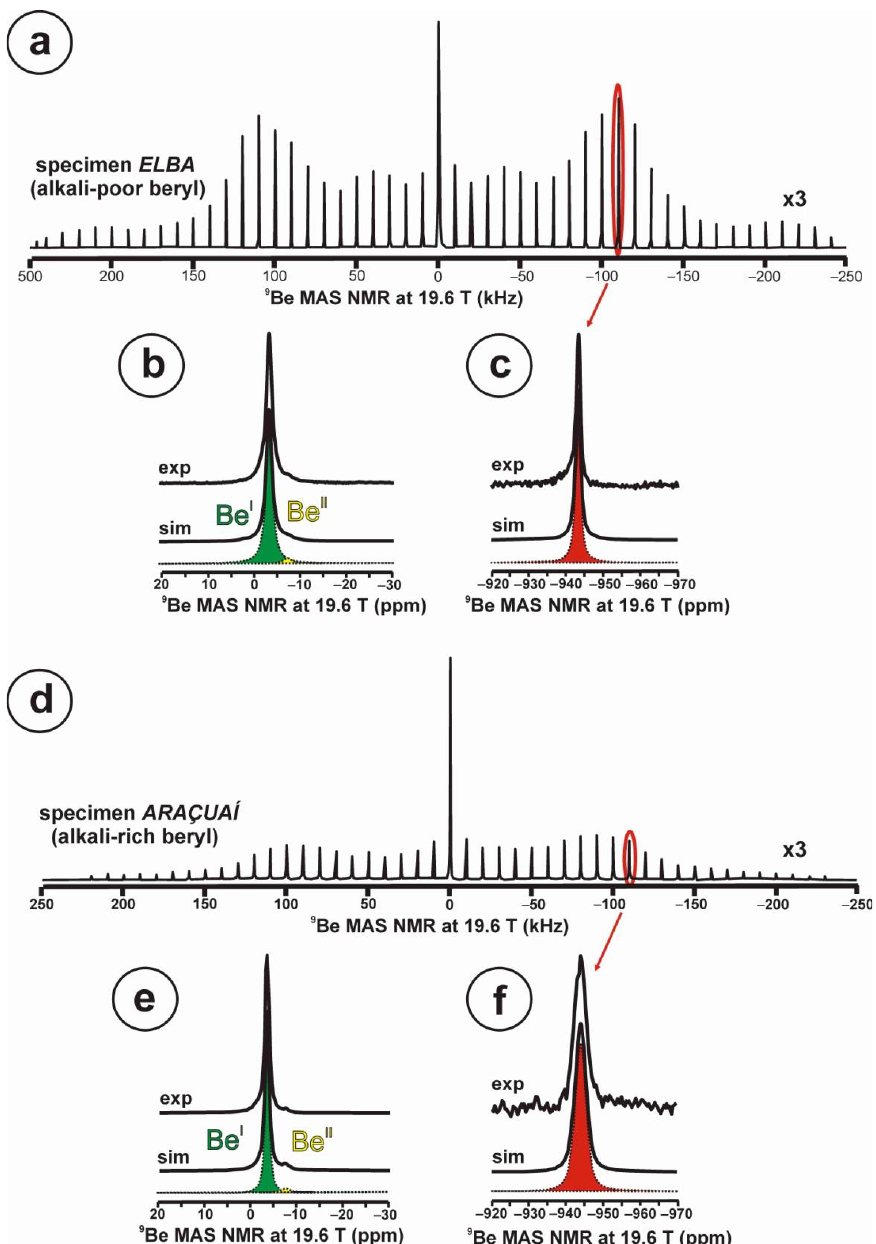
Figure 7. The 9 Be NMR MAS spectra at 19.6 T of beryl-group minerals, obtained using a 3.2 mm rotor, υ r = 10 kHz. ( a – c ) Specimen Elba or alkali-poor beryl shows a well-developed quadrupolar shape in the STMAS profile, with the shape of the central transition 1/2, green in ( b ), and the transition 3/2 red in ( c ). Two sites for Be atoms are resolved, Be I and Be II in ( b ). ( d – f ) Specimen Araçuaí or alkali-rich beryl has a less defined quadrupolar shape in the STMAS profile, with the same transitions and the same sites for Be atoms (see explanations in text). Experimental conditions: spin rate ν r = 10 kHz, using a 1.0 μs excitation pulse, 4 mm rotor, recycling delay 10 s.